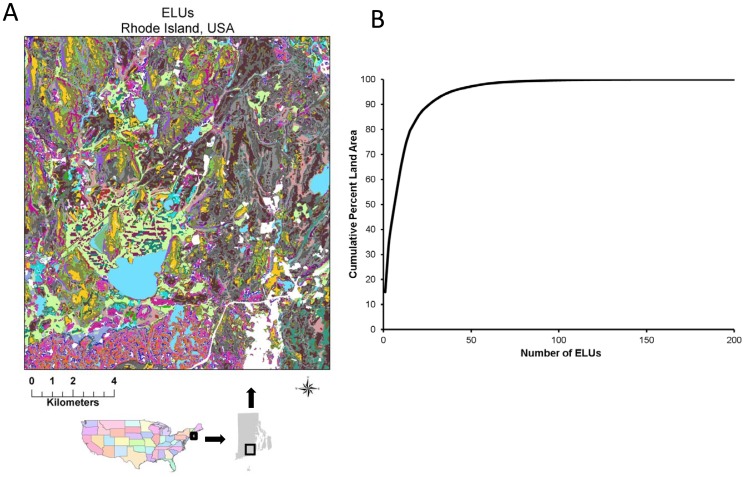
ELUs in Rhode Island.(A) Map showing ELUs for a Rhode Island landscape. (B) Cumulative distribution function for ELUs of Rhode Island.